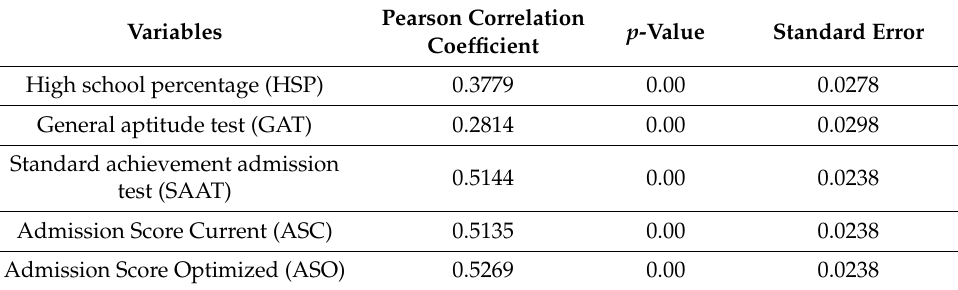
Table 2. Pearson correlation coefficient and p -value for features with the target variable.